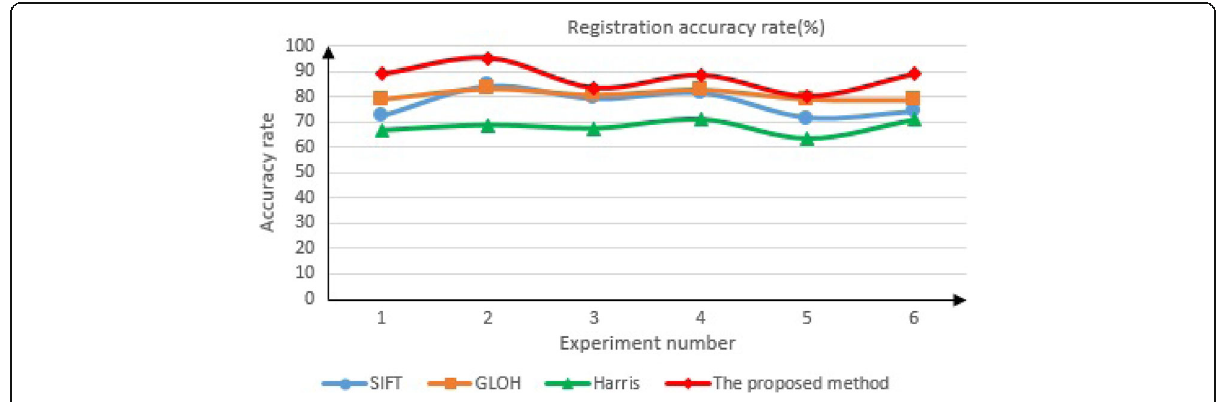
Fig. 7 The curve of registration accuracy comparison with some algorithms